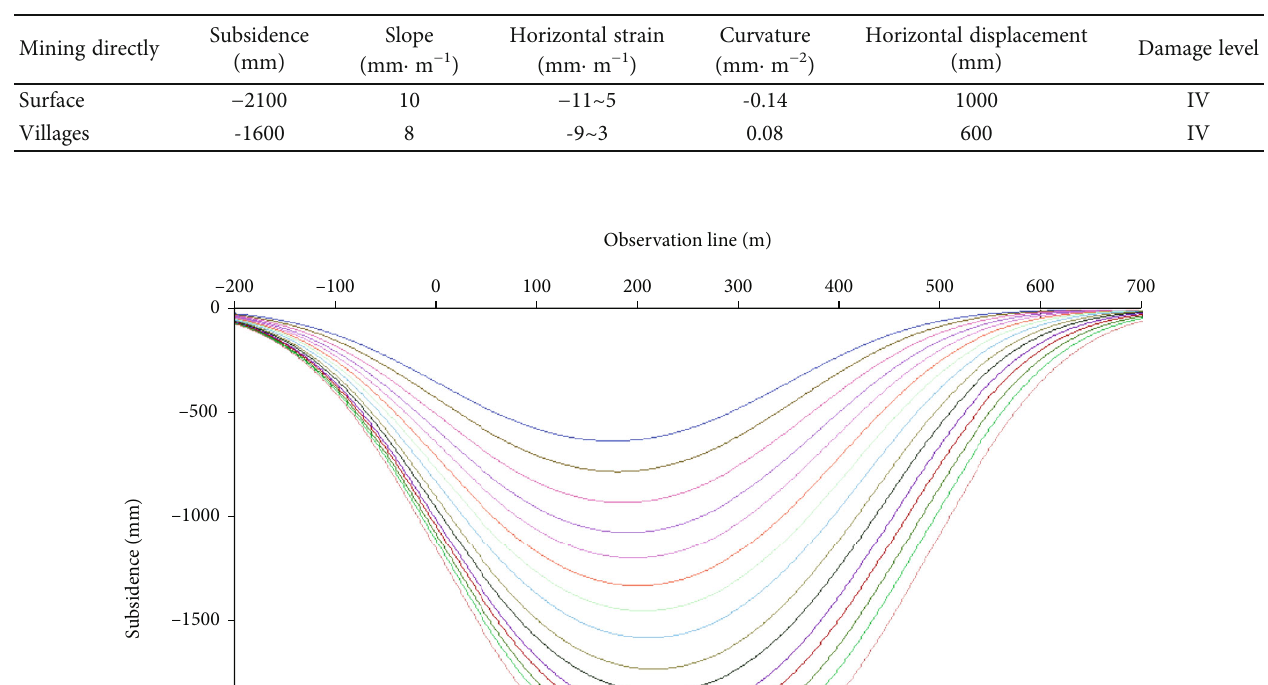
Table 2: Ground and villages deformation prediction without grouting.